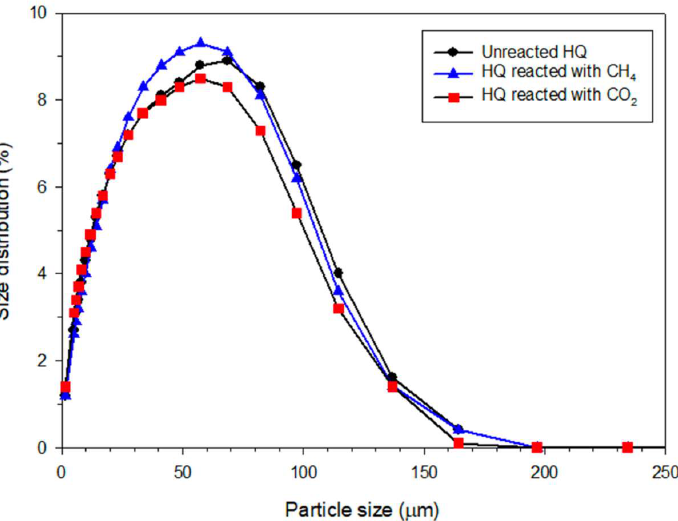
Figure 1. Accumulated size distribution of the ground HQ powders before and after the reactions with pure gases.